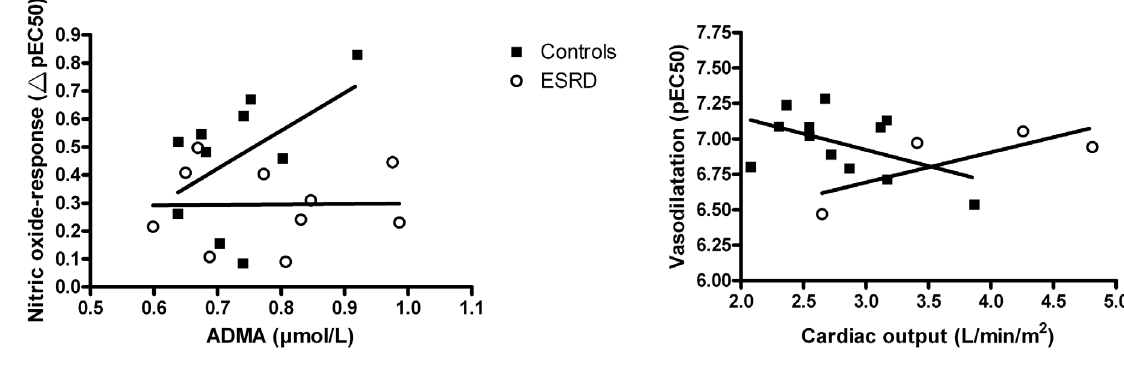
Figure 8. Association between cardiac output and vasodilata- tion (pEC 50 ) in controls (r= 2 0.50; p=0.05) and ESRD (r=0.76; p=0.12), Pearson one-tailed correlation.